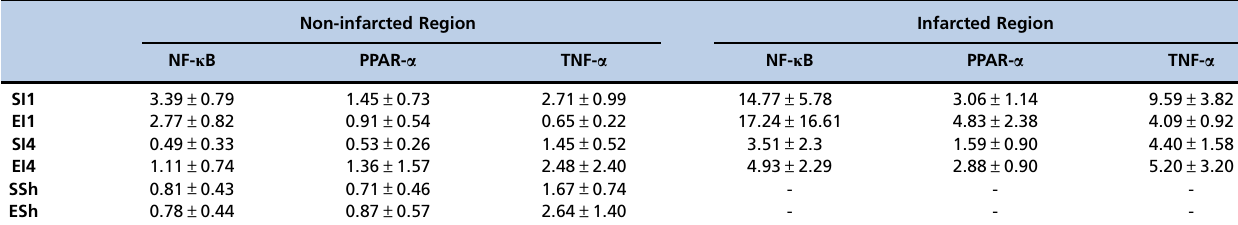
Table 2 - Mean ± SD of the positive percentage areas for PPAR- a , TNF- a and NF- k B in non-infarcted and infarcted regions. Non-infarcted